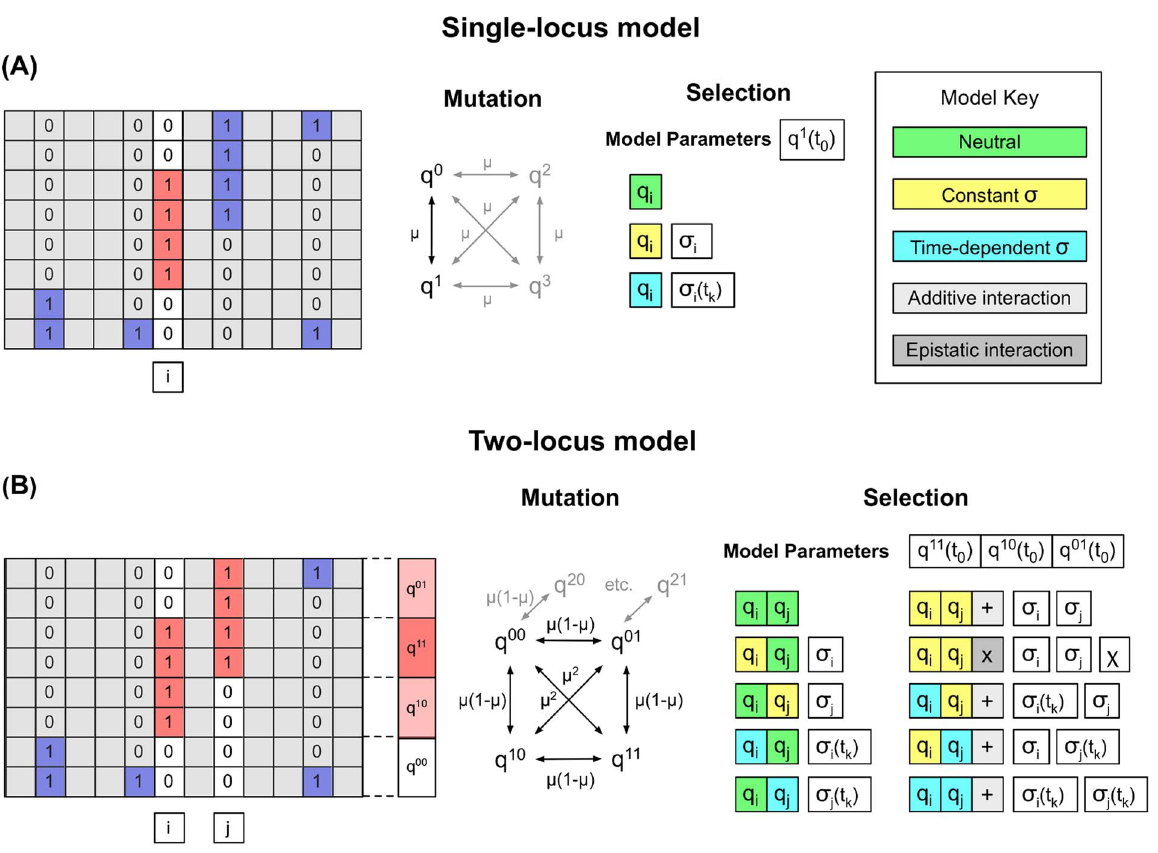
Figure 4. Models of selection. (A) Example single-locus model. A single allele, denoted 1 (red) at driver locus i is considered to be potentially under selection; the initial consensus allele is denoted 0. Changes in the frequencies of alleles at locus i are affected over time by mutation and selection; the alleles denoted 2 and 3 refer to the remaining two nucleotides at this locus. Changes in allele frequency are compared to those obtained under models in which the allele 1 is either neutral, or under constant or time-dependent selection; appropriate parameters for selection, and for the initial state of the system, are learnt. (B) Example two-locus model. We suppose that alleles at loci i and j have been found to exhibit apparent non-neutral behaviour, other alleles being indistinguishable from neutrality. We divide the population into haplotypes based upon the alleles present at these loci, giving haplotype frequencies q 11 , q 10 , q 01 , and q 00 . Observed frequencies are then compared to those obtained under a variety of models of selection at either one or two of these loci. In this figure, example sequences are shown for a single